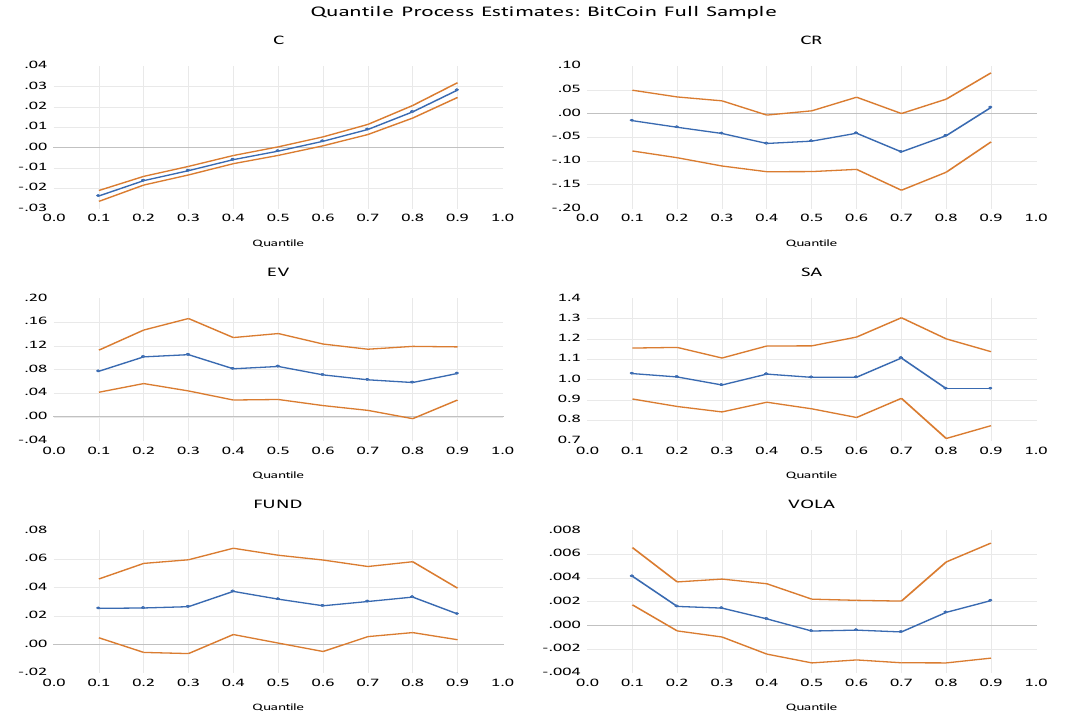
Figure 2. Quantile-Coefficients for Bitcoin in Full-Sample.